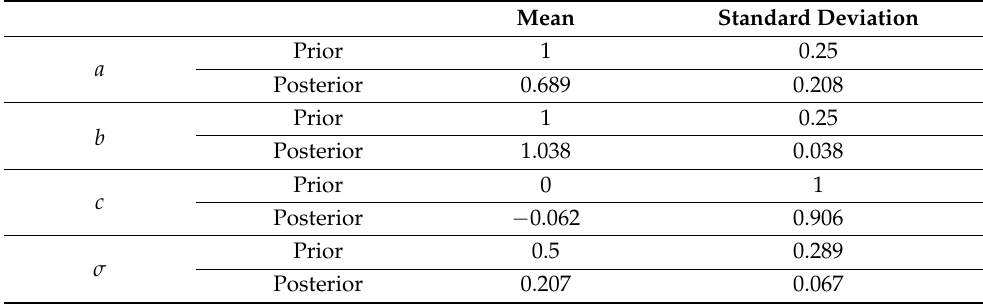
Table 2. Mean and standard deviation values of prior and posterior distributions of calibration